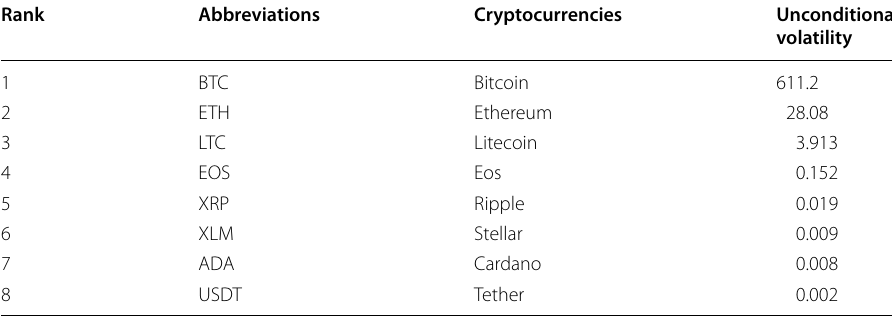
Table 7 The rank of unconditional volatility